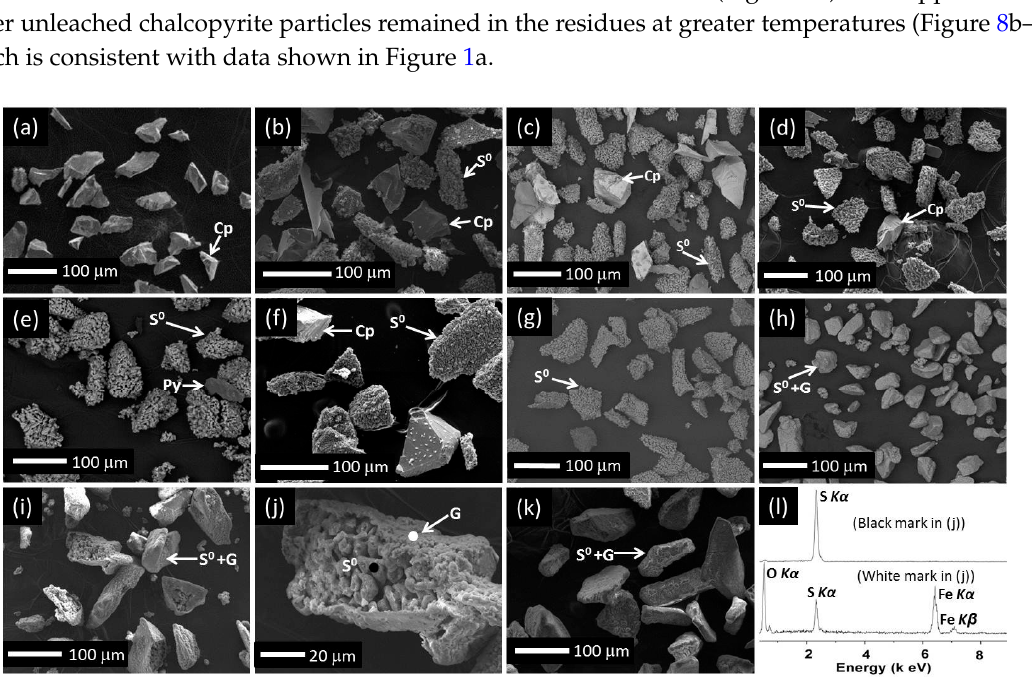
Figure 8. SEM images of final residues collected from leaches carried out at 750 mV, pH 1.0 without iron addition at: ( a ) 35 °C, ( b ) 43 °C, ( c ) 50 °C, ( d ) 65 °C, ( e ) 75 °C; pH 2.0 without iron addition at: ( f ) 35 °C, ( g ) 43 °C, ( h ) 50 °C, ( i ) 65 °C, ( j ) selected particle from ( i ), ( k ) 75 °C; ( l ) ED spectra from selected area shown in ( j ).